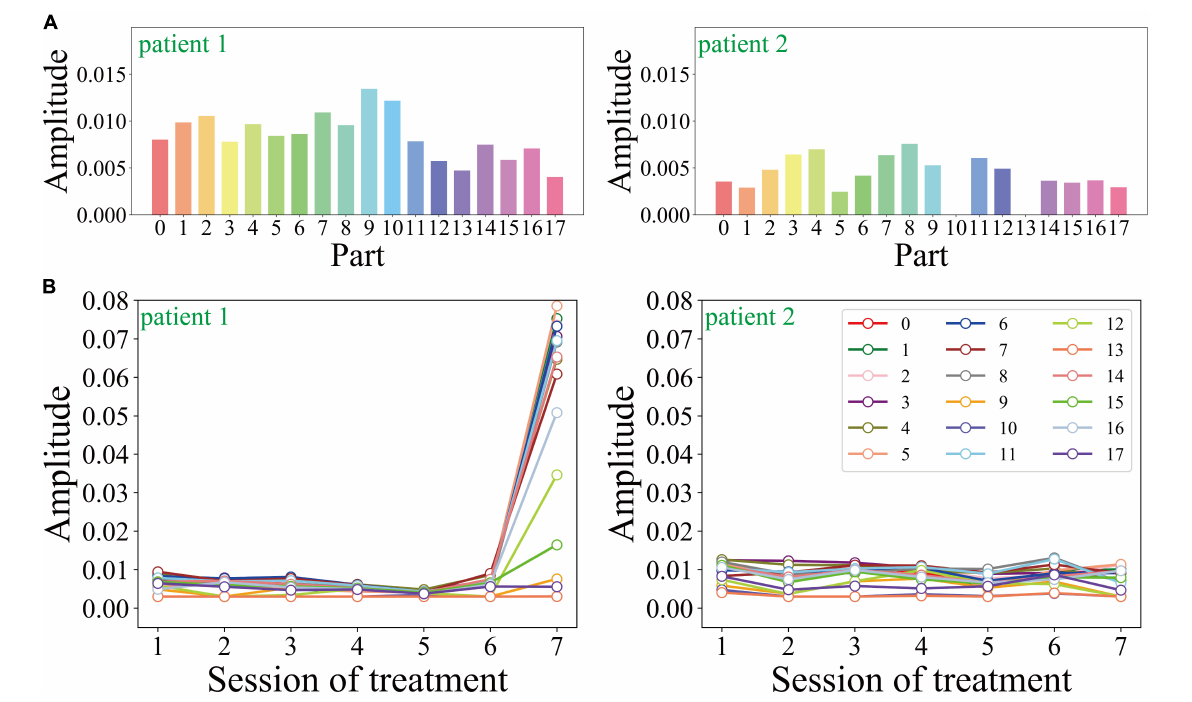
FIGURE4 (A) The action feature distributions of the two selected patients during the second session of treatment, and (B) the change of the action feature with the sessions of treatment.